Question: What kind of plot is shown here?
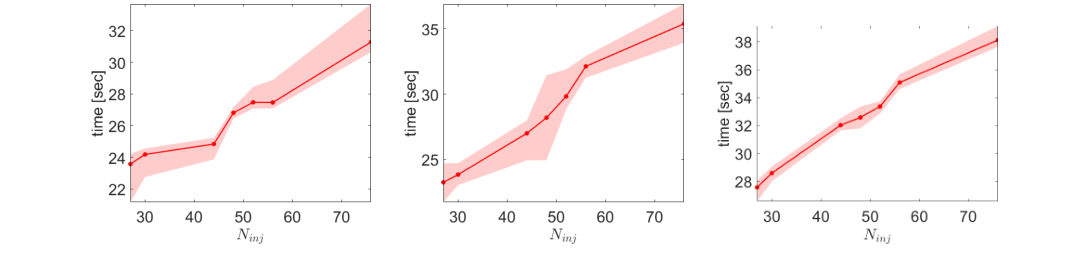
Answer: line